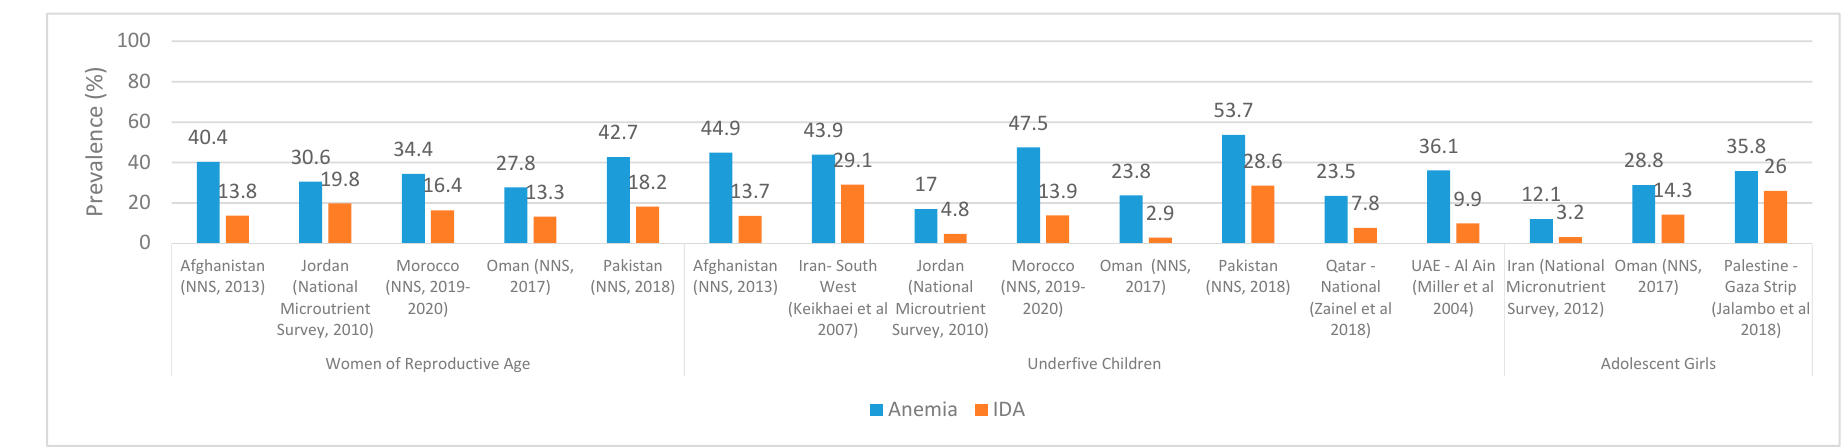
Figure 4. Prevalence of IDA vs. anemia amongst WRA, U5C, and adolescent girls based on studies that have reported on both. For Afghanistan, Iran, Jordan, Qatar, and the UAE, the values for WRA and U5C may differ from those reported in Table 1, since the values in the figure are based on studies that have reported on both IDA and anemia. Abbreviations: EMR: Eastern Mediterranean Region; IDA: iron deficiency anemia; NNS: National Nutrition Survey; U5C: underfive children; UAE: United Arab Emirates; WRA: women of reproductive age.